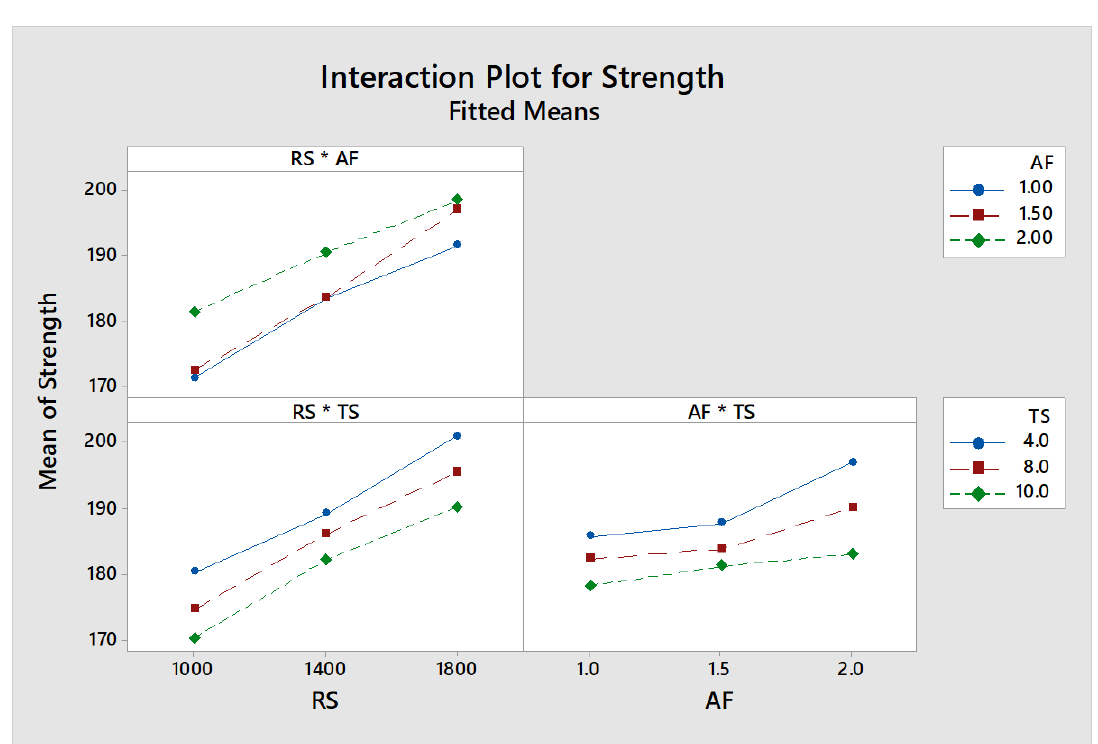
Figure 27. Interaction effect plot — strength.